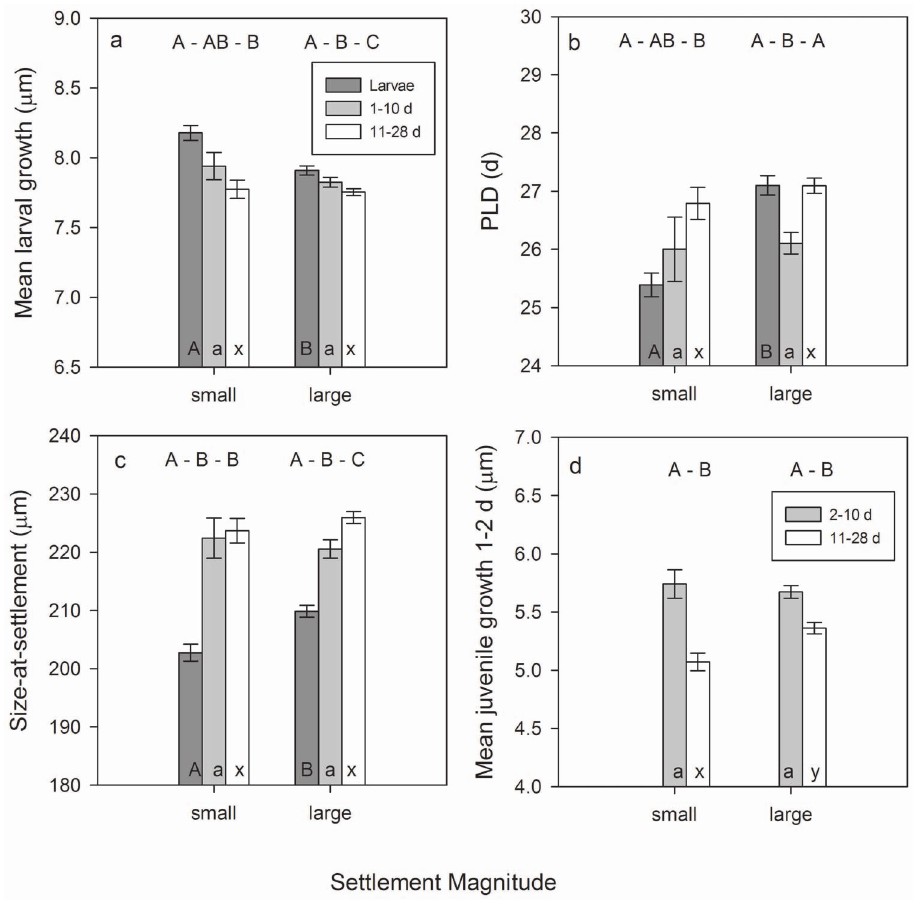
Figure 3. Mean otolith-derived (a) larval growth, (b) pelagic larval duration (PLD), (c) size-at-settlement, and (d) early (2 d) juvenile growth of Stegastes partitus settlement-stage larvae (dark gray bars), recruits (1–10 d post-settlement; light gray bars), and juveniles (11–28 d; white bars) by size of light trap pulse (larvae) and size of settlement event (recruits/juveniles). Effects of temperature and lunar phase were minimized by including only individuals from cohorts that encountered mean water temperatures of . 28 u C and settled during the darker half of the lunar cycle. Error bars are SE. Different letters above the bars indicate significant differences among age groups, within events of a given size. Different letters within the bars indicate significant differences between small and large events, within age groups (capital A, B denote differences within larvae, lowercase a, b denote differences within 1–10 d old recruits, lowercase x, y denote differences within 11–28 d old juveniles). Settlement-stage larvae are not included in the last panel because they had not yet settled so did not exhibit juvenile